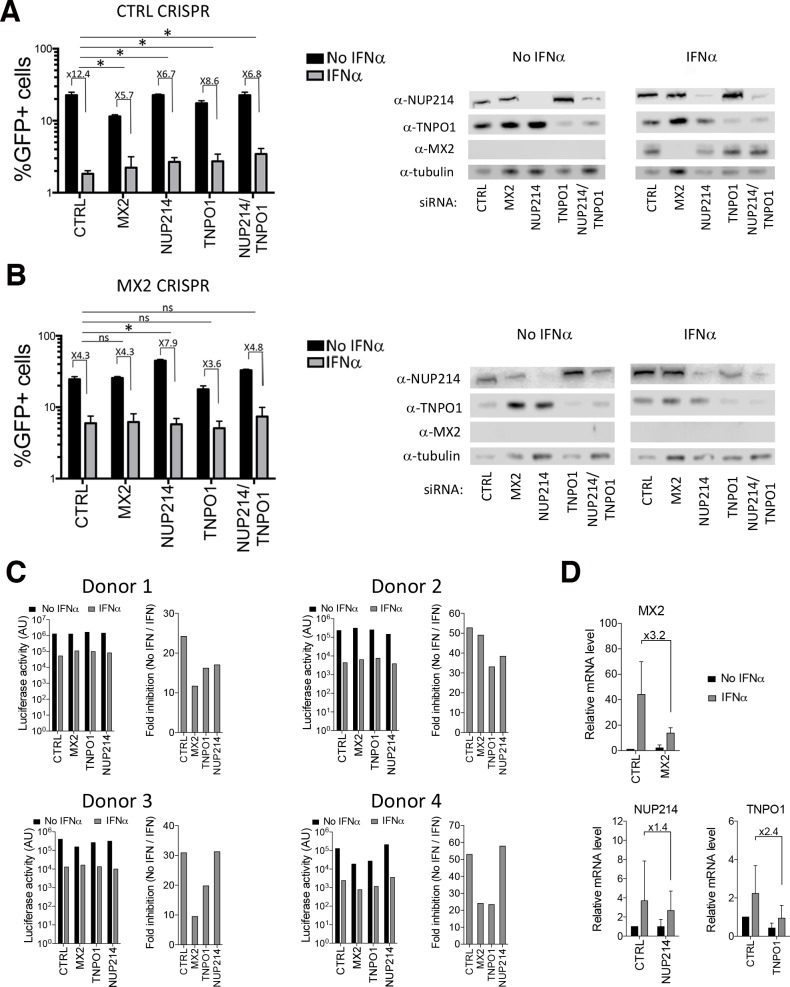
Endogenous MX2 requires NUP214 and TNPO1 for a full anti-viral function.(A) U87-MG cells transduced with a CRISPR-Cas9 control guide RNA were transfected twice with a control siRNA (CTRL) or siRNAs targeting MX2, NUP214 and/or TNPO1, and treated or not with 1000 U/ml of IFNα, prior to infection with an HIV-1/GFP lentiviral vector. On the left, the percentage of infected cells calculated by flow cytometry and the fold inhibition of infection due to IFNα treatment are shown (n = 4; mean ± SD; *p-value < 0.05; (ns) non-significant; paired t-test). On the right is an immunoblot from a representative experiment, showing depletion of the indicated proteins. (B) Same experiment as in A, but using U87-MG cells where the MX2 alleles were disrupted using CRISPR-Cas9 genome editing (n = 4; mean ± SD; *p-value < 0.05; (ns) non-significant; paired t-test). (C) Primary CD4+ T cells were isolated from 4 independent donors, transduced with shRNAs targeting MX2, NUP214, TNPO1 or a control shRNA (CTRL) and treated or not with 3000 U/ml of IFNα. 24 h later, cells were challenged with NL4.3/Nef-IRES-Renilla and luciferase activity determined 48 h later. The mean of three technical replicates are shown for each donor on the left, and the fold inhibition of infection (no IFN/IFN) on the right. (D) Efficiency of MX2, NUP214 and TNPO1 depletion in primary CD4+ T cells following shRNA transduction was quantitated by qPCR and normalized to GAPDH. Data shown represent 4 donors used in (C).